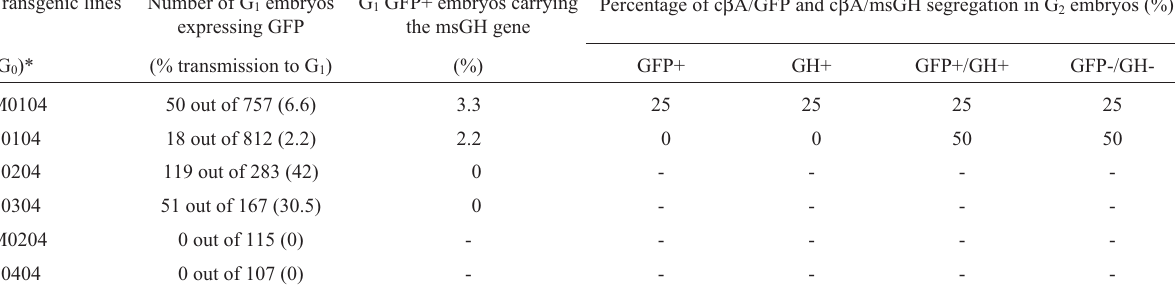
Table 1 - Germline transmission and expression of a green florescent protein (GFP) reporter transgene (c β A/GFP) and growth hormone transgene (c β A/msGH) in transgenic zebrafish ( Danio rerio ). Transgenic